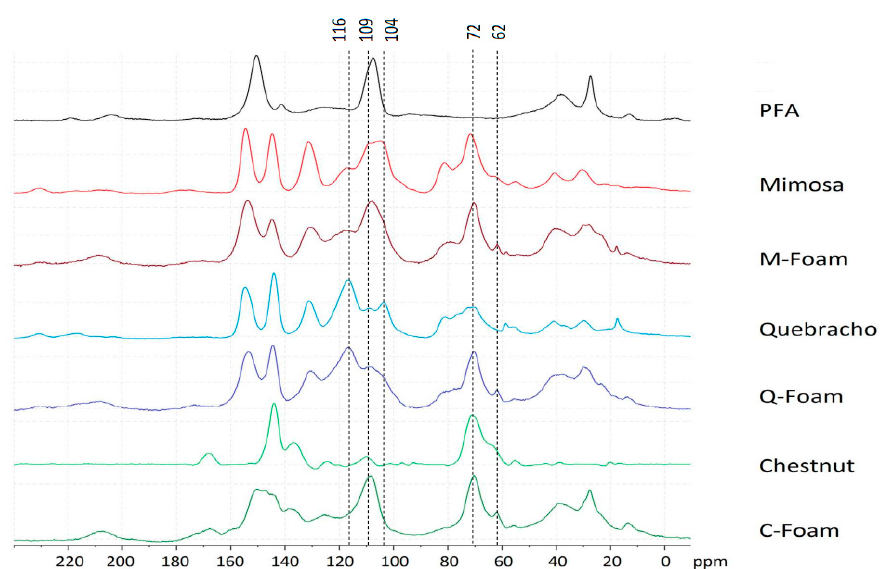
Figure 6. 13 C-NMR spectra of polyfurfuryl alcohol, mimosa, quebracho and chestnut tannin extract and their derivative foams.